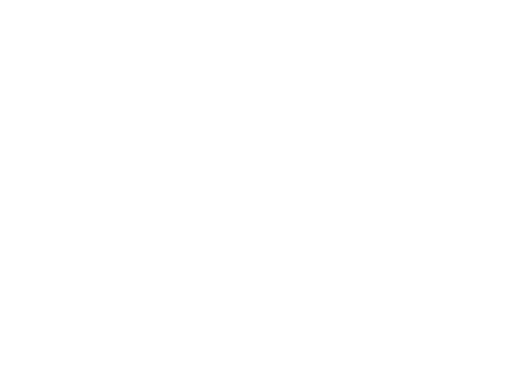
Table 2. Top 10 metabolites that contributed most to the predictive